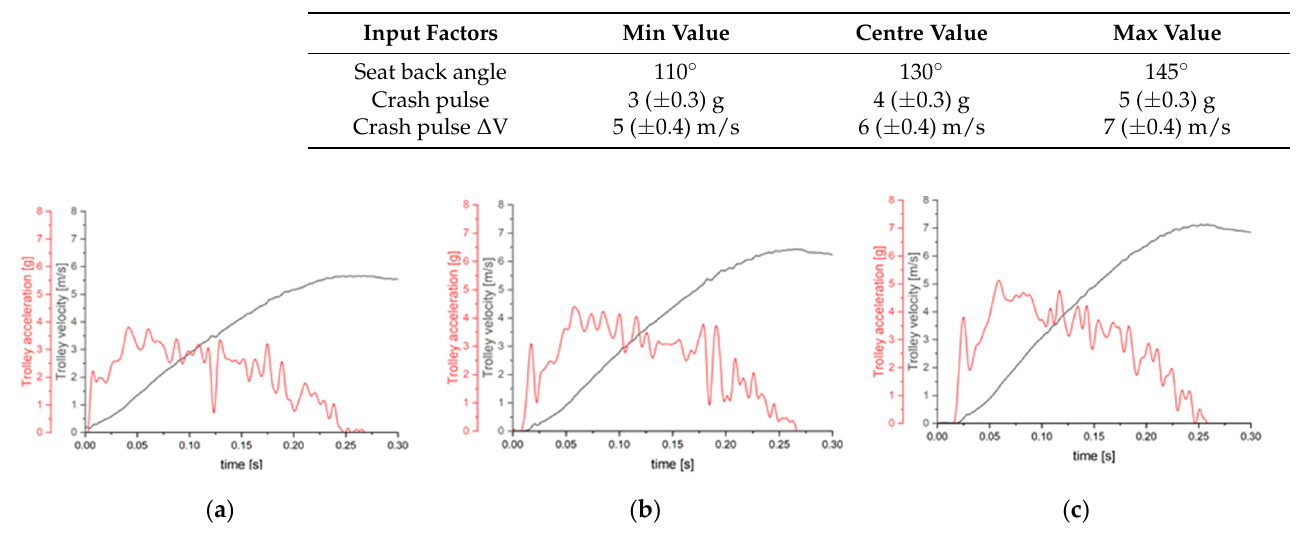
Figure 1. Crash pulses: ( a ) crash pulse 3 [g]; ( b ) crash pulse 4 [g]; ( c ) crash pulse 5 [g].